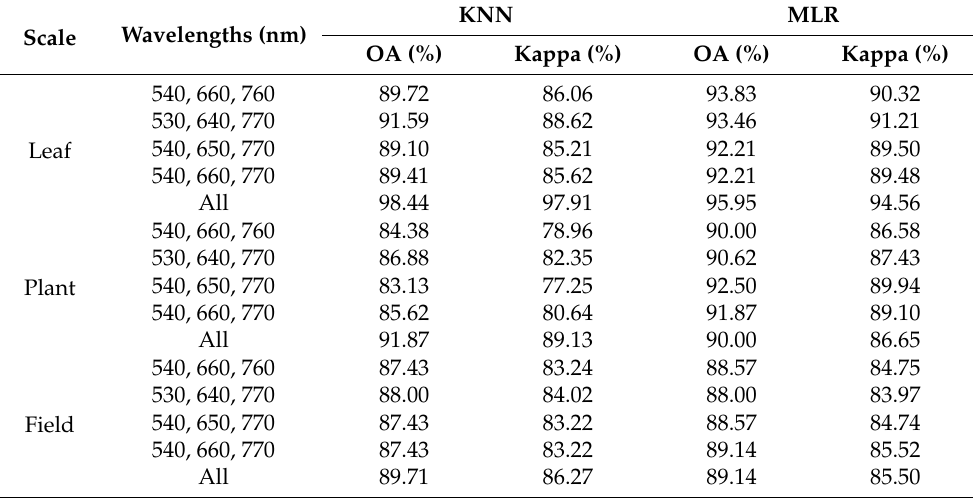
Table 6. Classification results of individual-scale sensitive wavelengths, multi-scale sensitive wavelengths, and full wavelengths.